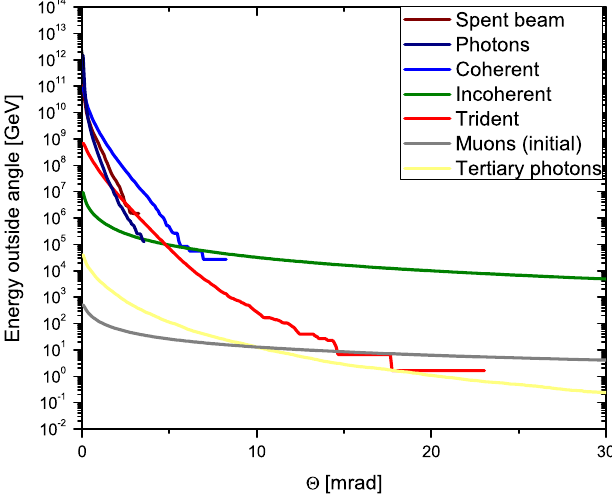
FIG. 1. Energy distributions of the disrupted particles produced at the IP as functions of angular cut. The muons shown here do not include the effect of